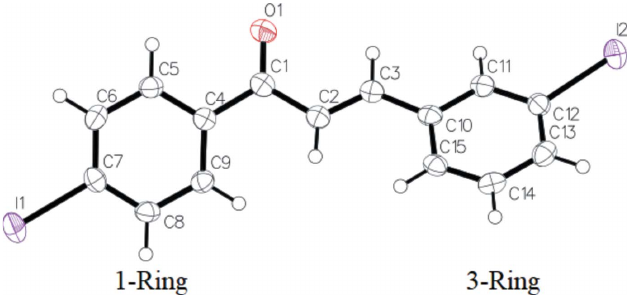
Figure 1 The molecular structure of the title compound, showing the atom labelling and displacement ellipsoids drawn at the 50% probability level.